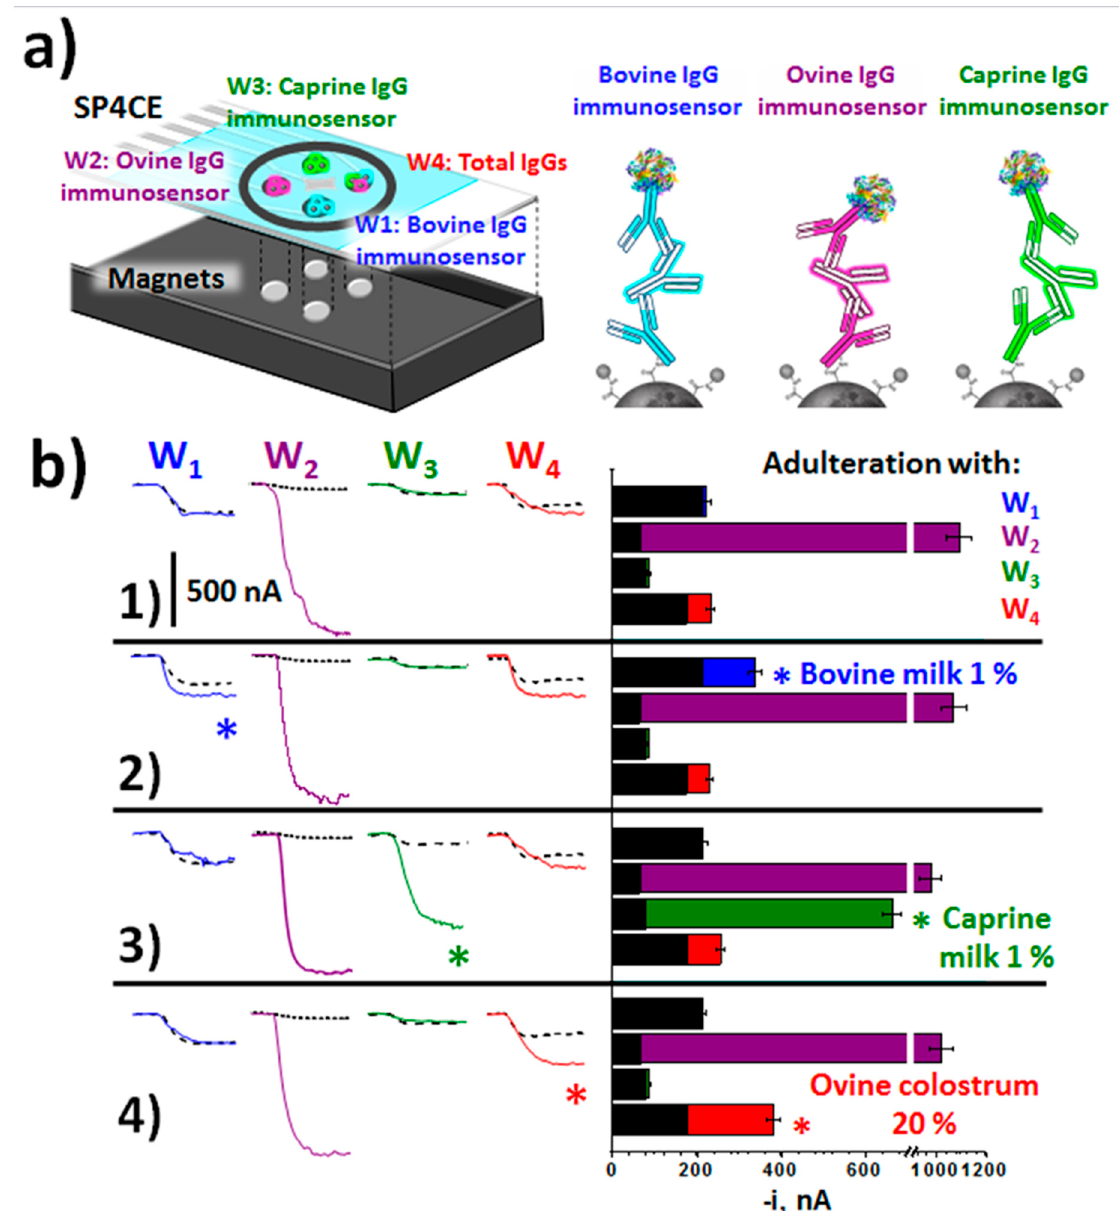
Figure 3. ( a ) Multiplexed MBs-based electrochemical immunoplatform for the detection of adulteration in milk by targeting bovine, ovine, caprine, and total IgGs in milk samples at SPC4Es. ( b ) Amperometric traces and measured currents (bars) in the analysis of 100 (W1–W3) or 10,000 times (W4) diluted raw sheep milk: unadulterated ( 1 ) or adulterated with 1.0% raw bovine milk ( 2 ), 1.0% raw caprine milk ( 3 ), and 20% ovine colostrum ( 4 ). For comparative purposes, amperometric traces recorded in the absence of bovine, ovine, and caprine IgGs (bu ff ered solutions) are displayed as black striped bars. Figure drawn based on